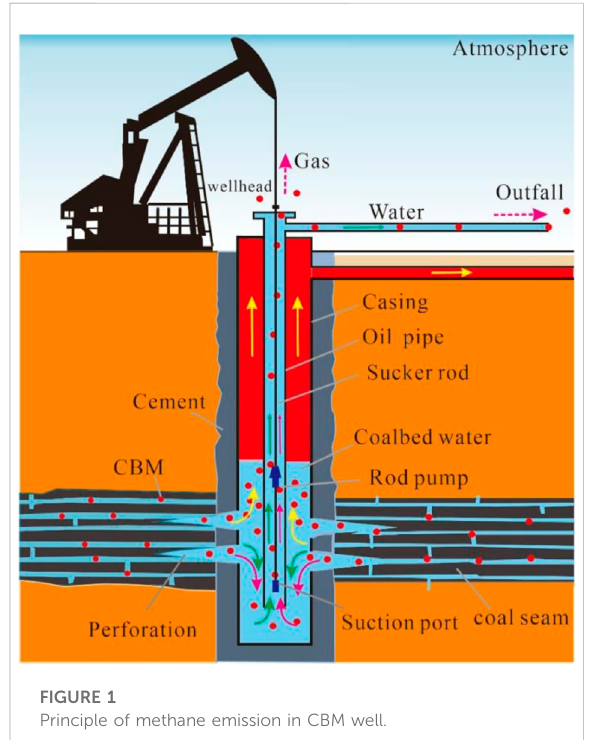
FIGURE 1 Principle of methane emission in CBM